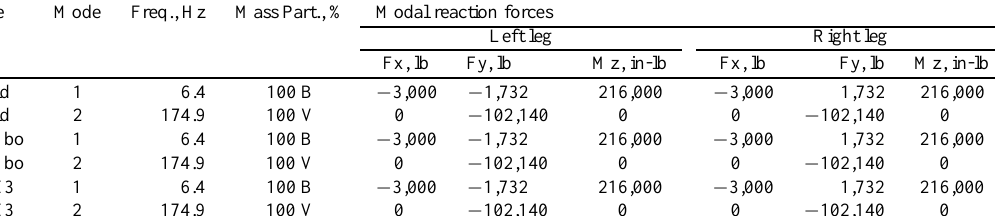
Table 3 Shock analysis results for other cases; Symmetric structure and mass